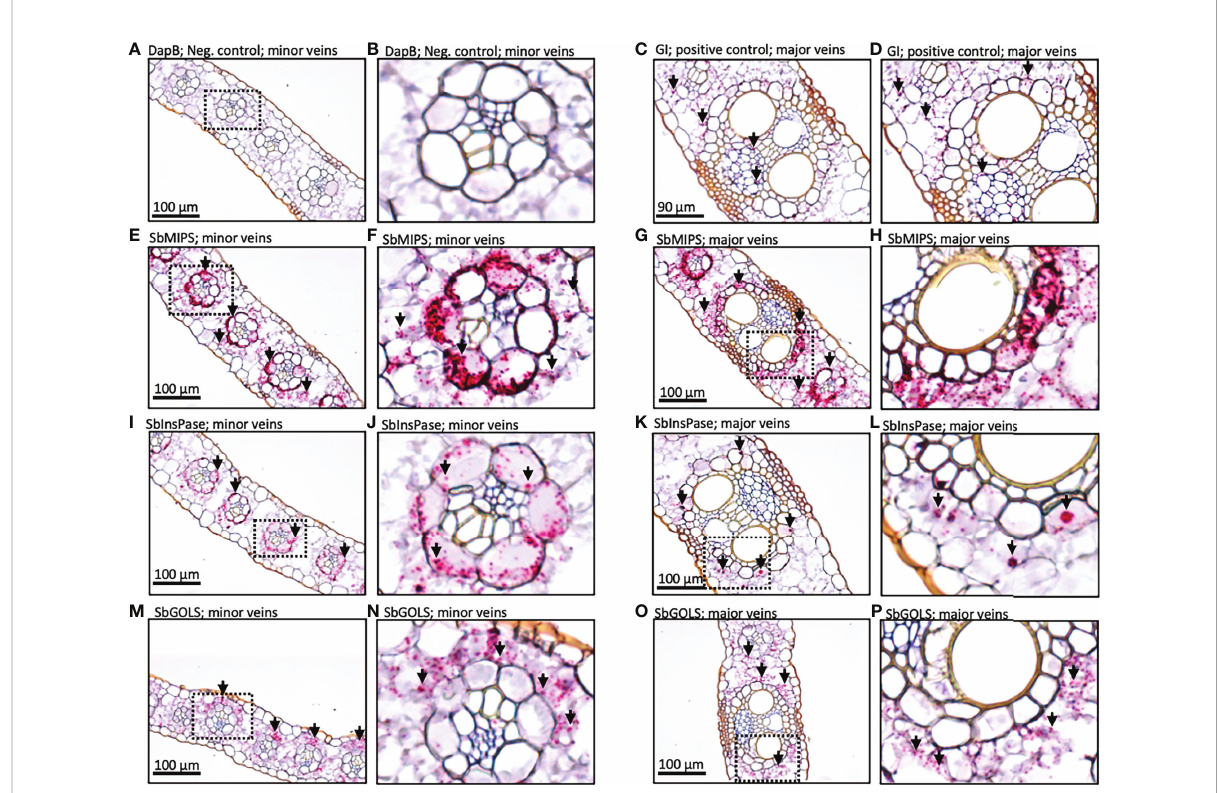
FIGURE 7 In situ localization of SbMIPS, SbInsPase, and SbGolS1 transcripts in Della leaves. Red punctate structures indicate the location of transcripts. 20X objective. Dashed line boxes in images on the left show where the zoomed in images to the right are focused. (A, B) show negative DapB controls in leaves. (C, D) show positive Gigantea controls in leaves. (E & F, I & J, M & N) show RFO pathway localization of expression in the minor veins of the leaf. (G & H, K & L, O & P) show RFO pathway localization of expression in the major veins of the leaf. Red punctate structures indicate the location of